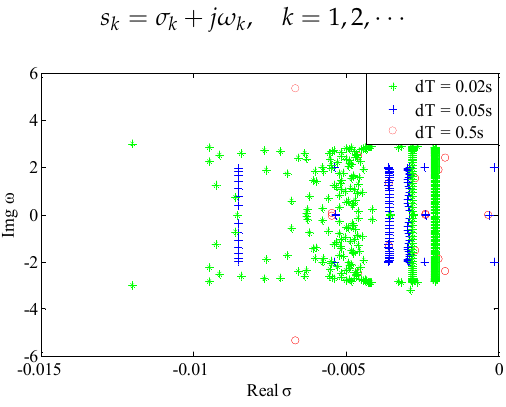
Figure 8. Diagram of characteristic points for RAECM with variable space discretization.